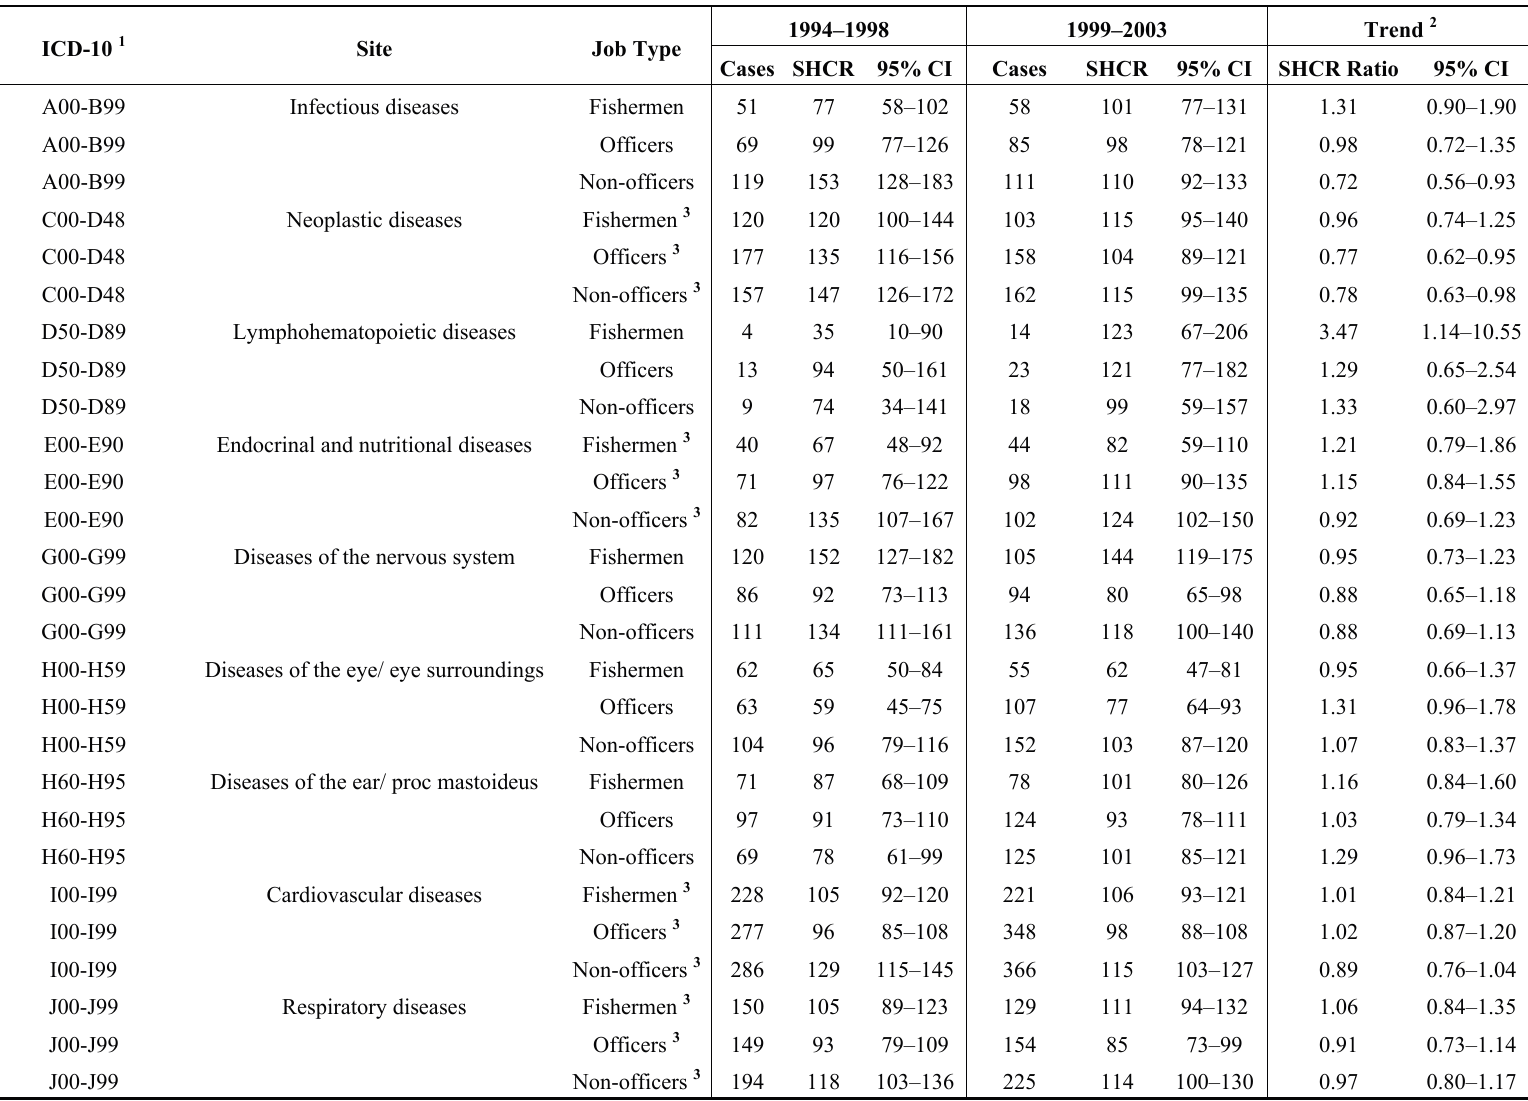
Table 2. Standardized hospital contact ratios (SHCR) 1994–2003 among Danish fishermen and seamen by job type and time period (men) 2